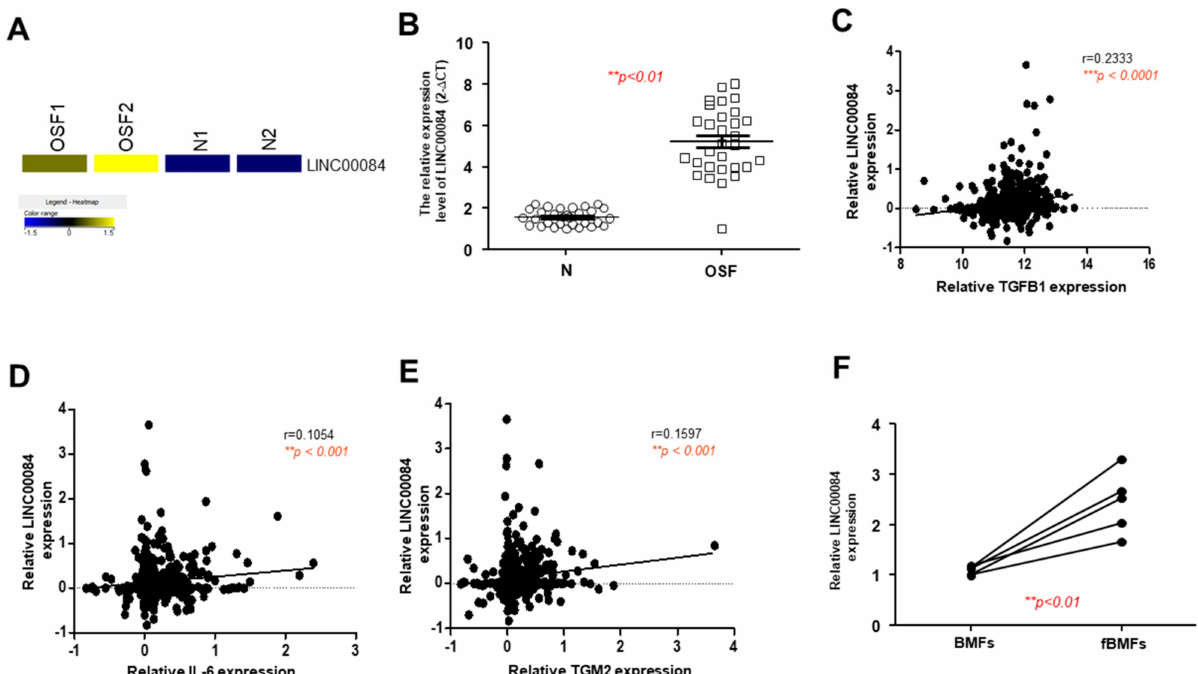
Figure 2. The expression of LINC00084 is aberrantly upregulated in OSF tissues and patient-derived BMFs. ( A ) A heatmap showing LINC00084 was highly expressed in two OSF and normal buccal mucosal tissues; ( B ) the relative expression of LINC00084 in normal and OSF specimens ( n = 30); analysis of the relationship between LINC00084 and various OSF- associated factor, including TGF- β ( C ), IL-6 ( D ), and TGM2 ( E ) using OSCC data from the cancer genome atlas (TCGA); and ( F ) the relative expression of LINC00084 in normal human BMFs and fibrotic BMFs (fBMFs) derived from OSF tissues. ** p < 0.01; *** p <